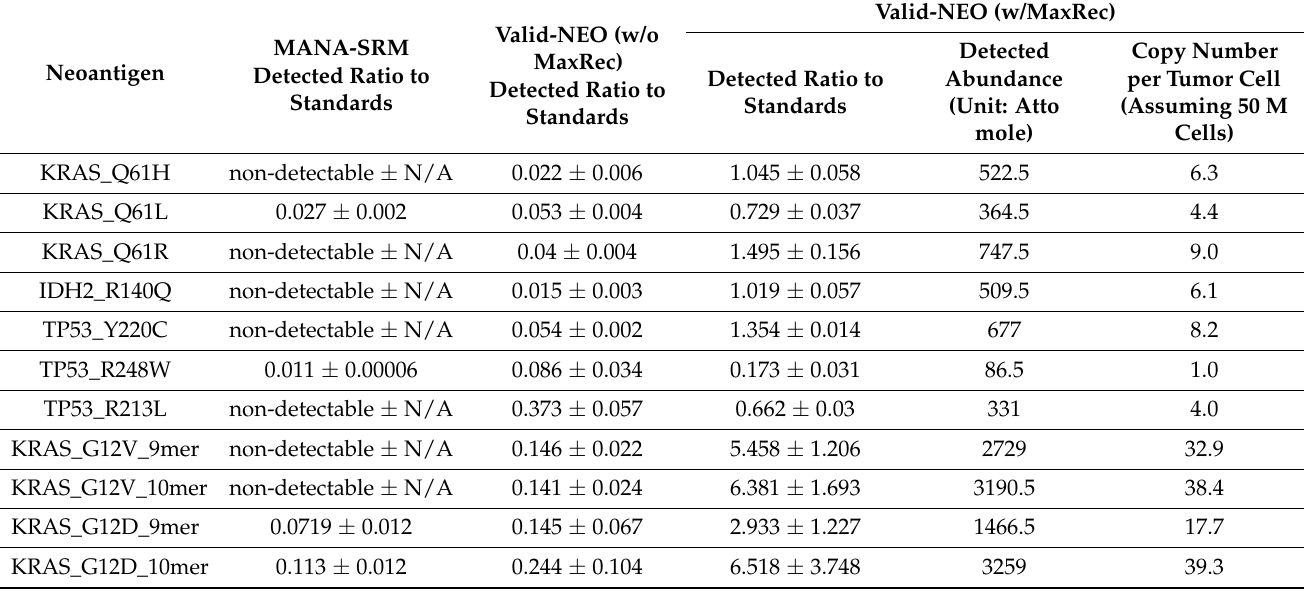
Table 1. Neoantigen quantification from small quantities of fresh frozen tissue through different